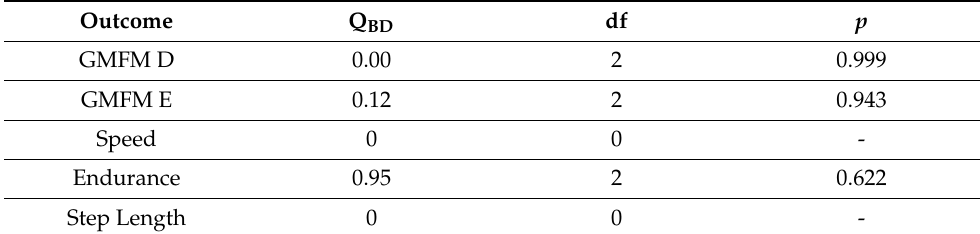
Table 5. Between-design Q